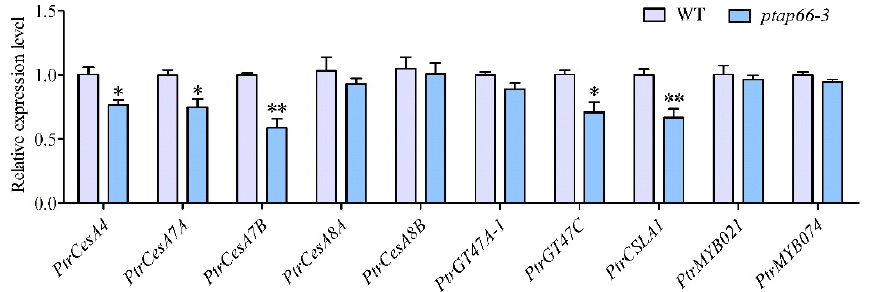
Figure 7. Expression analysis of genes associated with SCW synthesis in WT and ptap66-3 plants. The PtActin2 was used as an internal control. Error bars represent ± SD of three biological repeats. Asterisks indicate significant differences between ptap66 and WT plants by Student’s t -test (* p < 0.05 and ** p < 0.01).